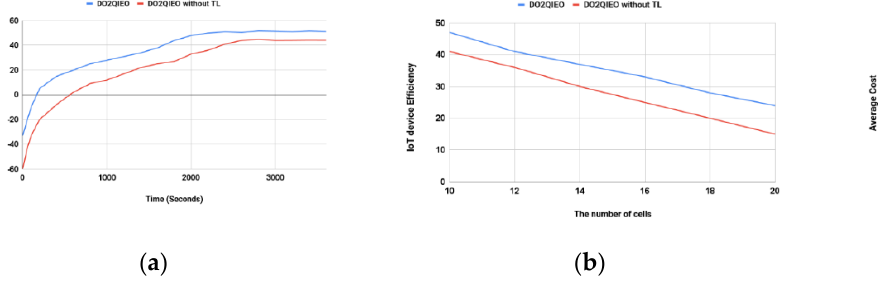
Figure 5. The IoT device efficiency in different scenarios, over time slot ( a ), The IoT device efficiency over the number of cells ( b ), and average cost versus cell count using TL and without it ( c